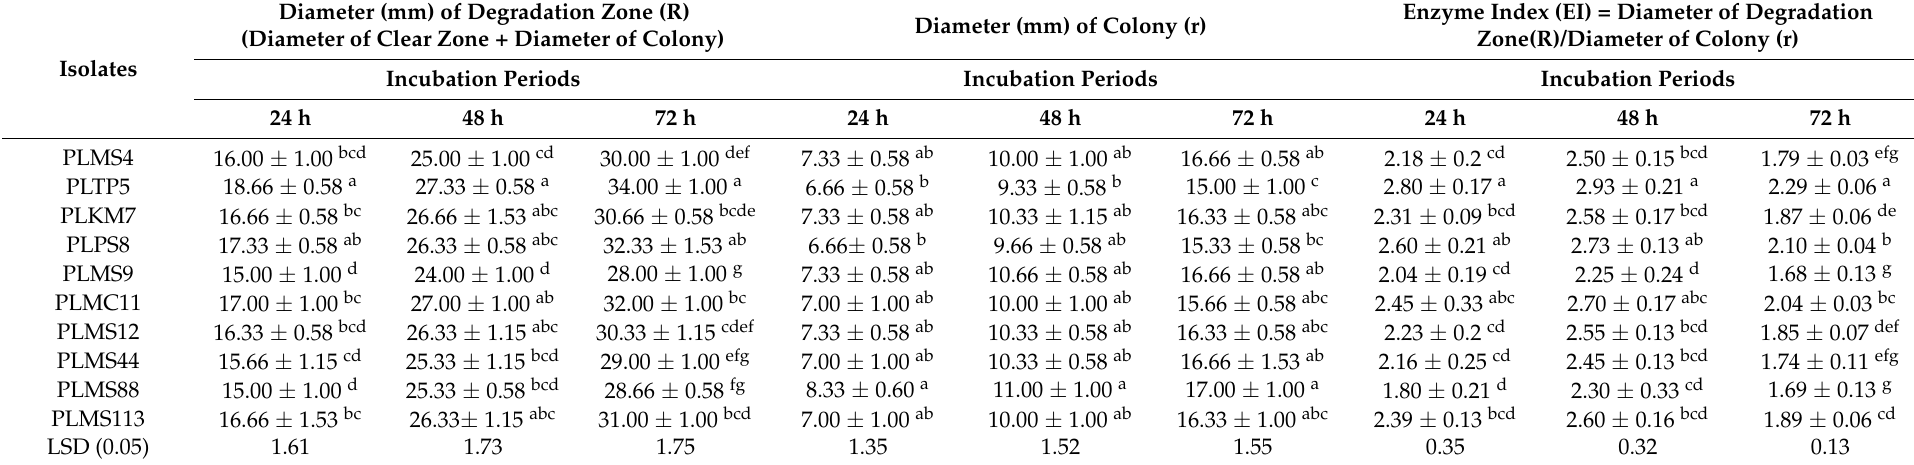
Table 1. Enzyme Index (EI) of the protease producing fungi